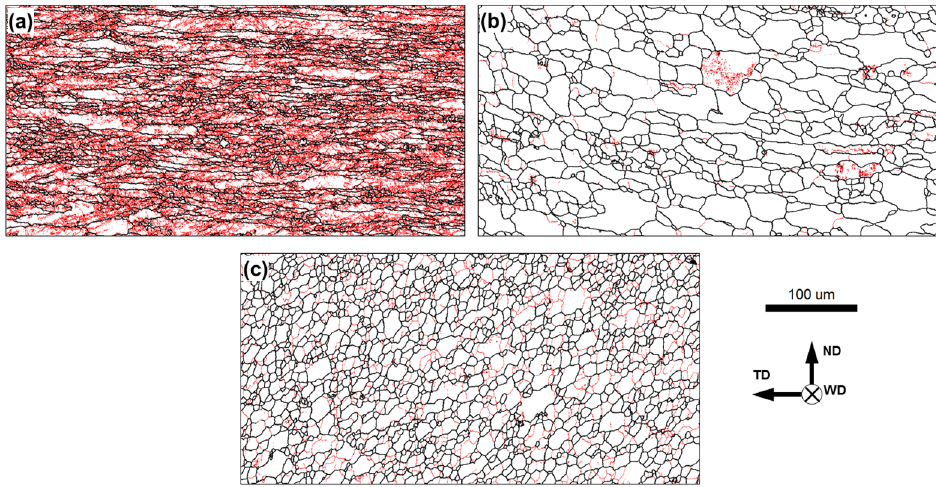
Figure 10. Typical EBSD grain boundary maps showing microstructure in ( a ) initial material, ( b ) heat-affected zone, and ( c ) stir zone. In the maps, low-angle boundaries (LABs) and high-angle boundaries (HABs) are depicted as red and black lines, respectively. The scale bar and reference frame for all maps are shown in the bottom-right corner. Note: EBSD data were taken from the welded joint of AA6013 alloy produced at the welding speed of 12.7 mm/min.